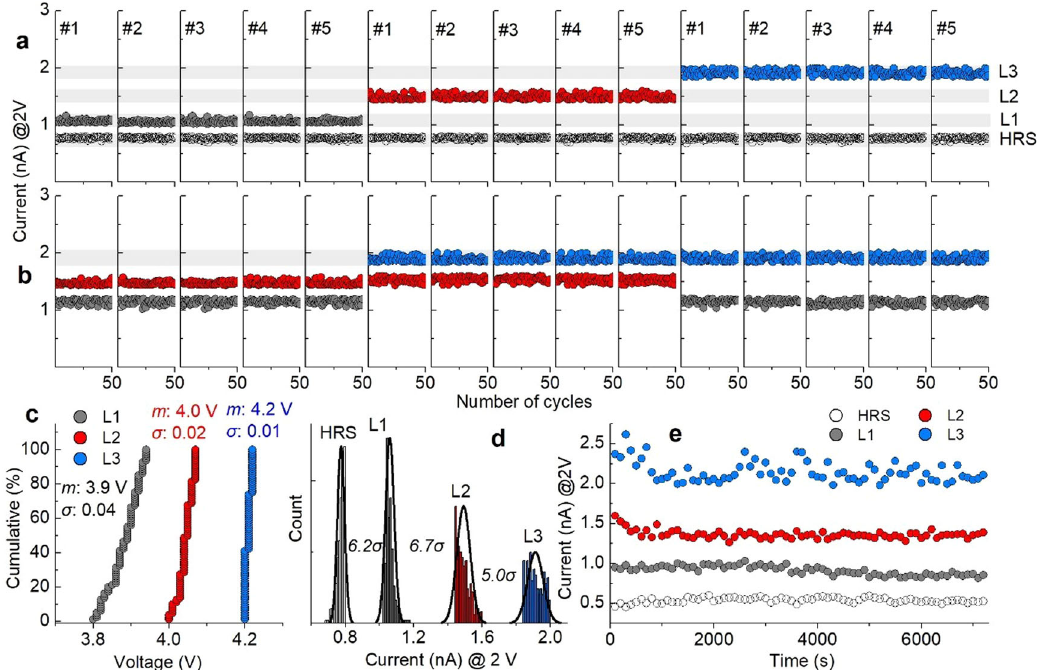
Fig. 5 Two-bit states of SRMC. Two-bit states programmed using a erase-and-program scheme and b erase-free scheme on fi ve SRMCs (indexed #1 – #5). c Cumulative distribution of amplitudes of two-bit programming pulses. Average amplitude and standard deviation denoted by m and σ . d SOP between two-bit states. e Retention of two-bit states at 85